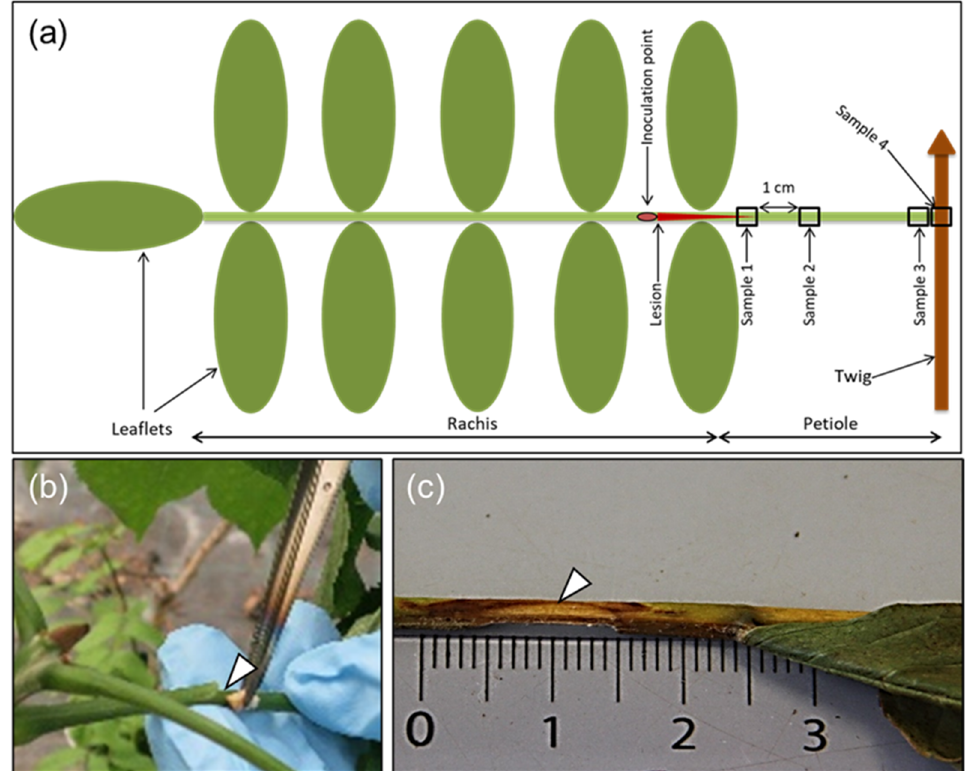
Figure 1. Illustration of rachis sample types, rachis inoculation, and necrosis development in ash. ( a ) A diagram indicating the rachis inoculation site and petiole sampling positions (shown as numbered frames): sample 1 (referred to as S1 in the text and tables), at the border of the lesion enclosing parts of the visible necrosis; sample 2 (S2), 1 cm from border of lesion; sample 3 (S3), base of petiole; sample 4 (S4), junction between petiole and twig. ( b ) Procedure for the inoculation of rachises with an ash wood plug colonized by the pathogen. ( c ) A characteristic necrotic lesion showing an extension from the inoculation site, 16 weeks after inoculation.